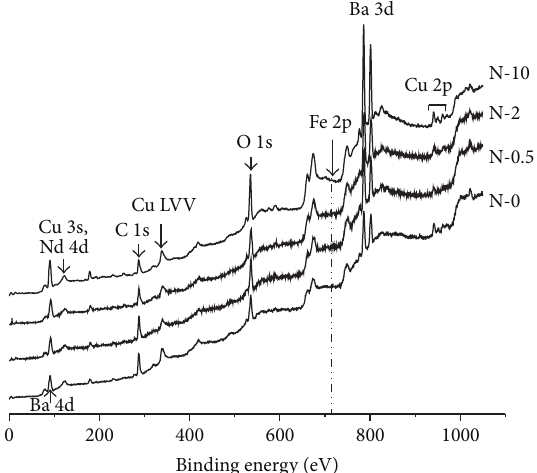
Figure 4: XPS survey spectra of the initial and mechanoactivated NdBa 2 Cu 3 O 6+𝛿